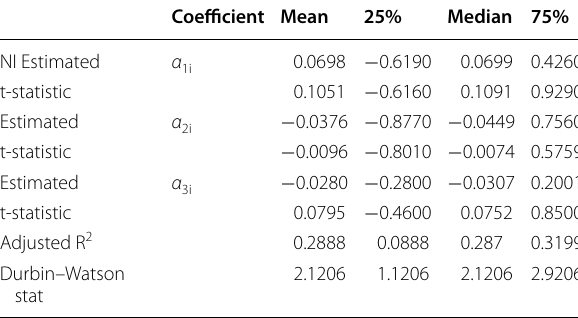
Table 4 Earnings and its components/Dutch companies